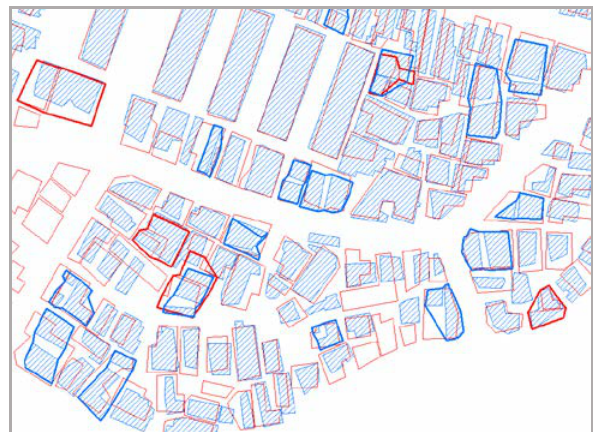
Figure 3. Changing several polygons into a single feature (thick line)